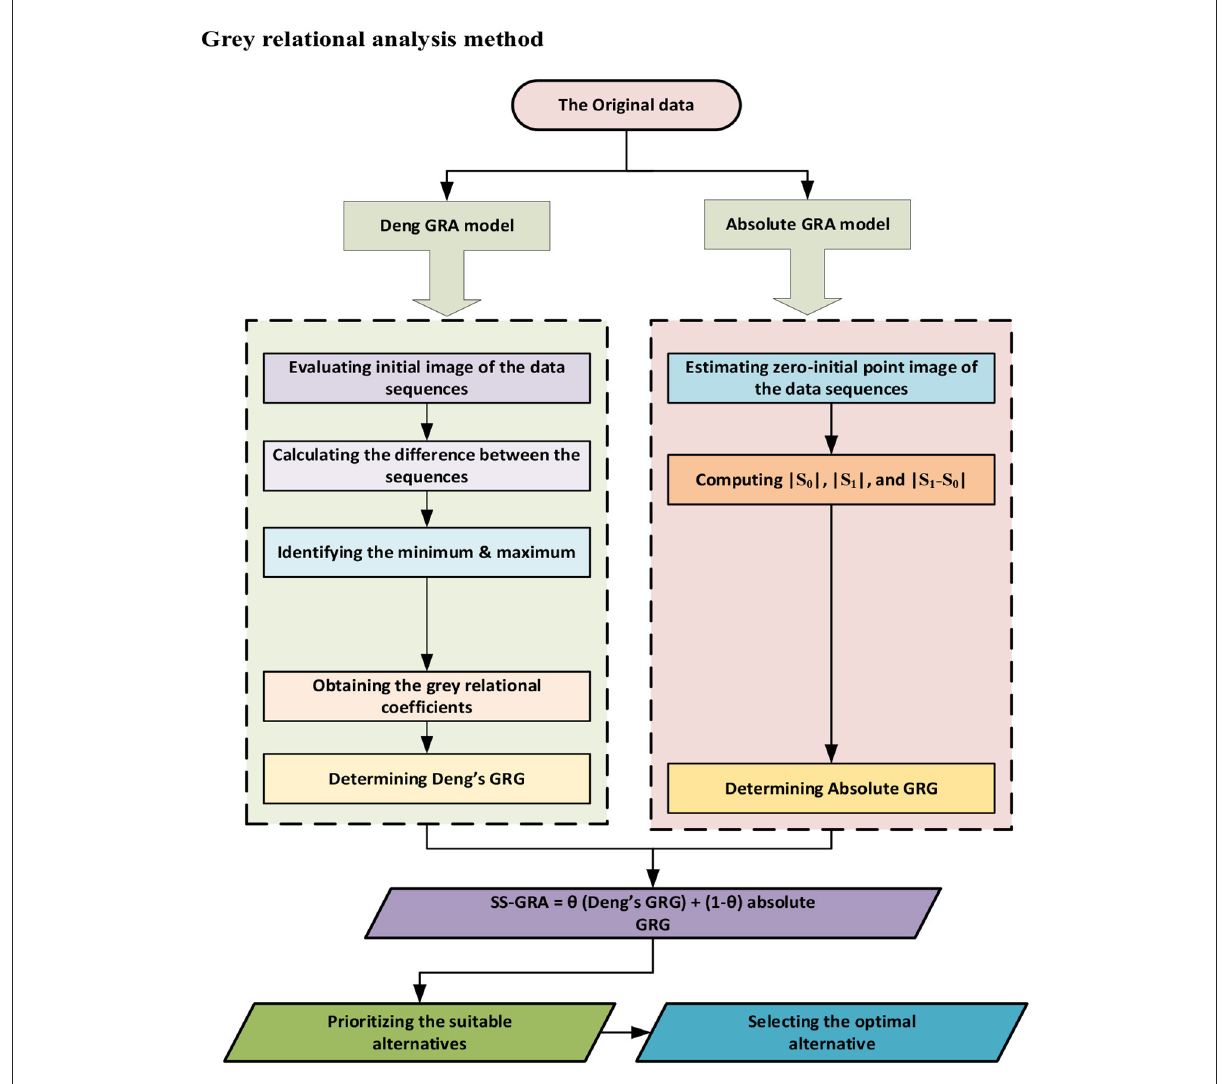
FIGURE2 The operationalized framework of grey relational analyses (GRA).